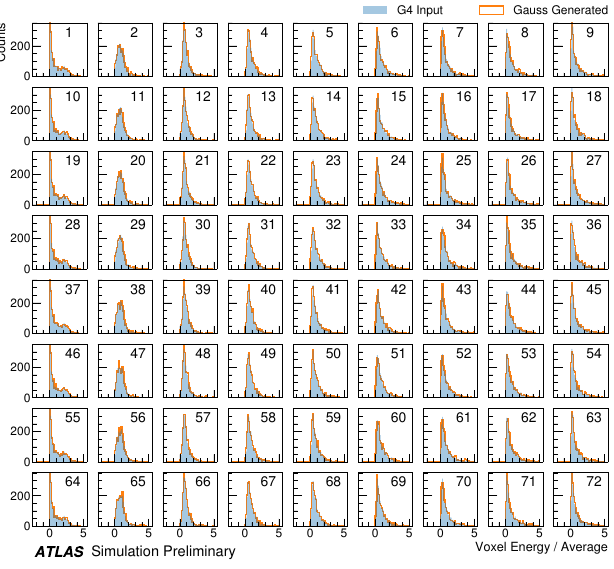
Figure 3. Distribution of the ratio of voxel energy in single events to the corresponding voxel energy in the average shape, with Geant4 events in blue and Gaussian model events in orange, for 65 GeV central pions in EMB2. Moving top to bottom corresponds to increasing α , left to right corresponds to increasing R , with core voxels numbered 1, 10, 19, .... Agreement is quite good across all voxels. Results are similar for the VAE method